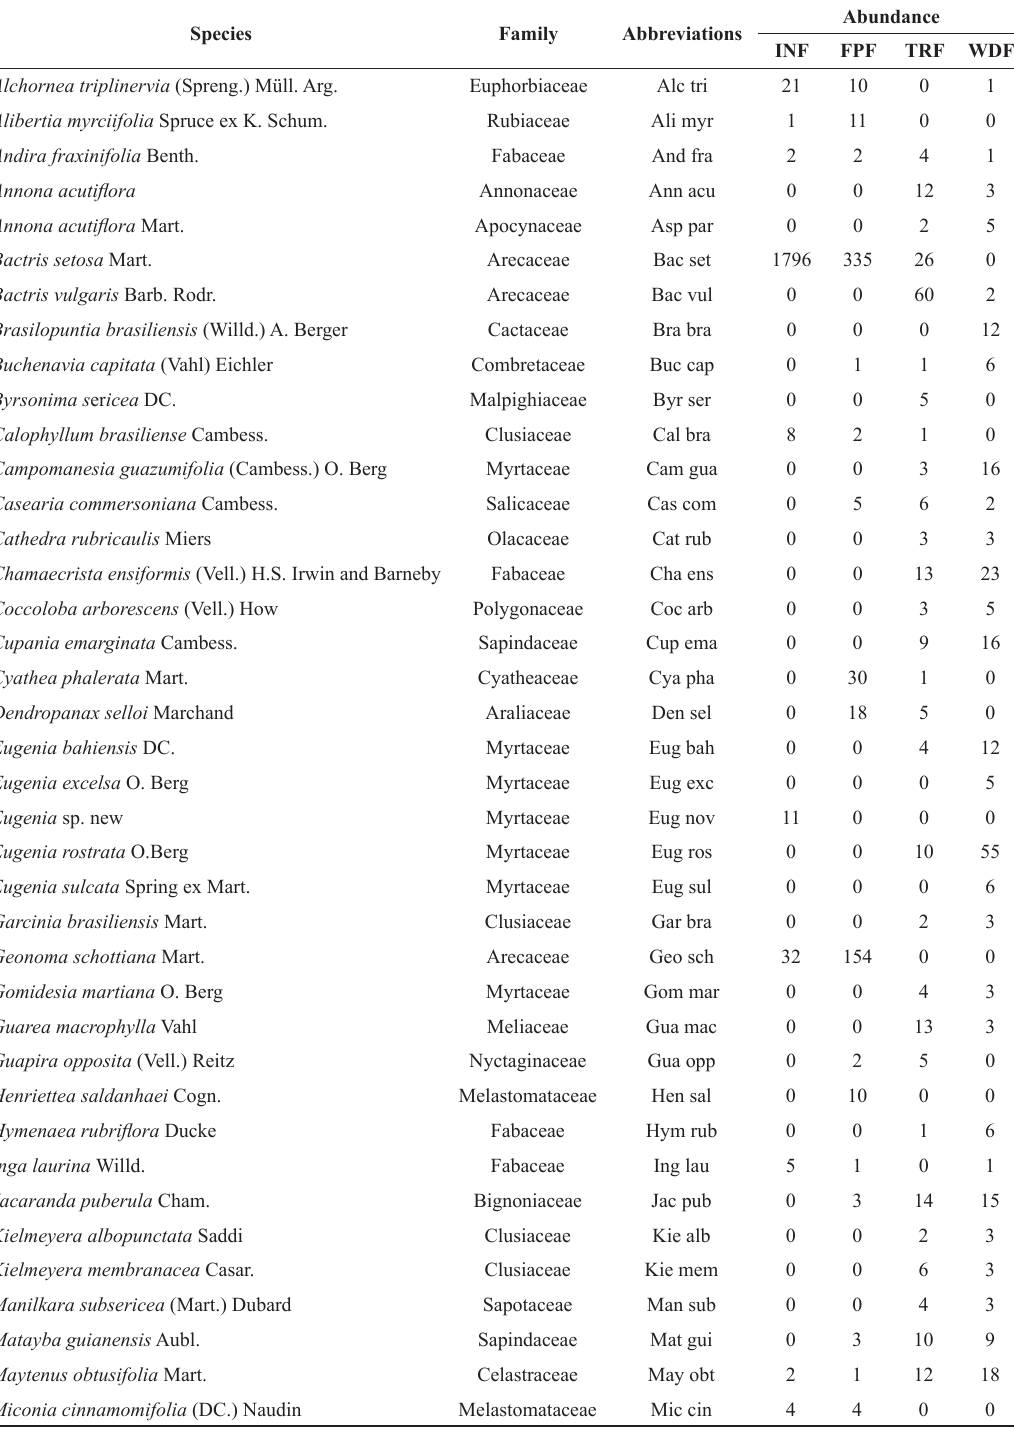
Woody species used in Canonical Correspondence Analysis (CCA) and their abbreviations, for the four forests types studied in Jacarenema Natural Municipal Park, Vila Velha, Brazil. INF=Inundated Forest; FPF=Floodplain Forest; TRF=Transitional Forest; WDF=Well-drained